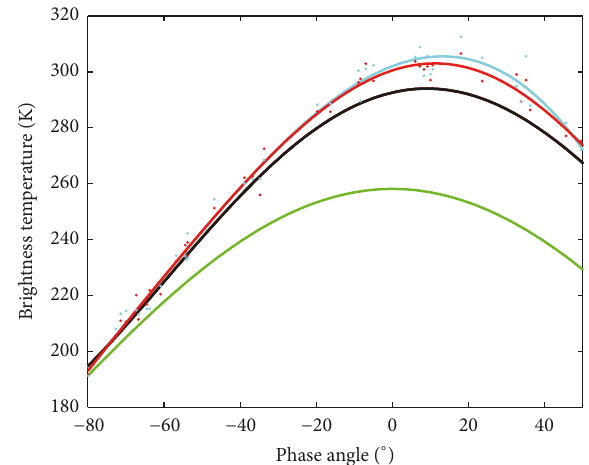
Figure 6: Disk-integrated brightness temperature of the Moon for different phase angles relative to full Moon. Green: Equation ( 4 ) and Table II in [4], 183.3 GHz, black: Keihm ([13], numbers for 183.3 GHz from web page and personal communication), red: MHS on NOAA-18, 183.3 GHz, and cyan: MHS on NOAA-18, 190.3 GHz, single measurements (dots) fitted with polynomial of order